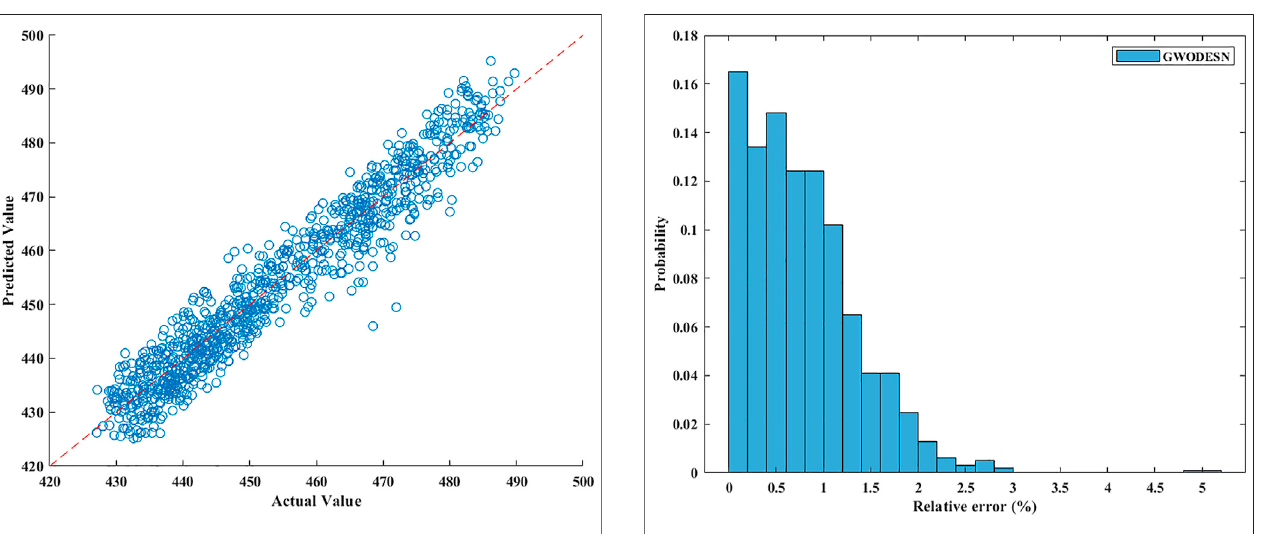
FIGURE 12 | Scatter diagram of the real value and the anticipated value for CCPP.